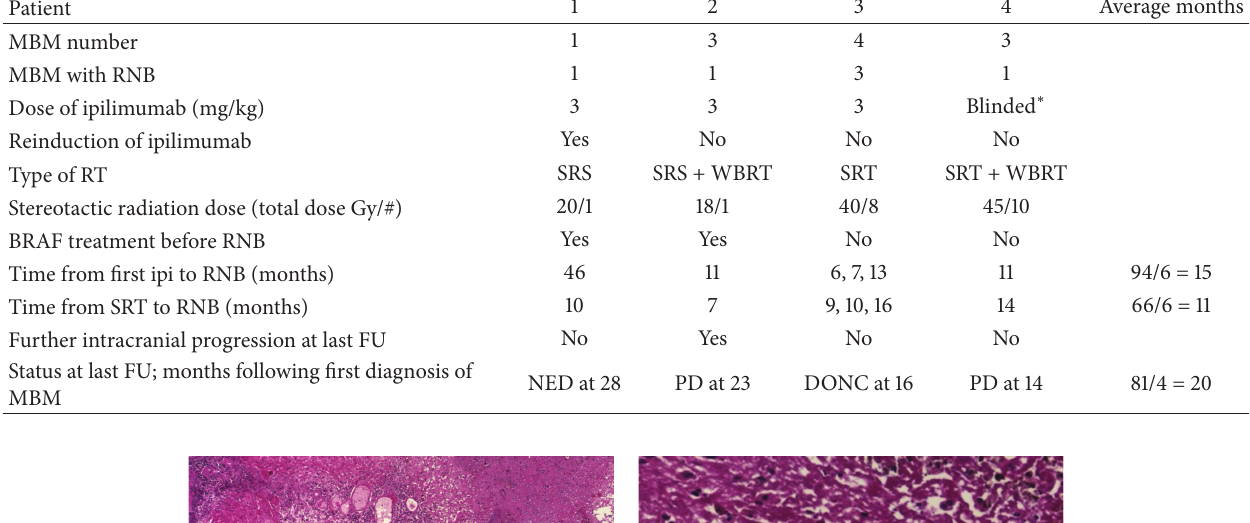
Table 1: Overview of the clinical history of the four patients.